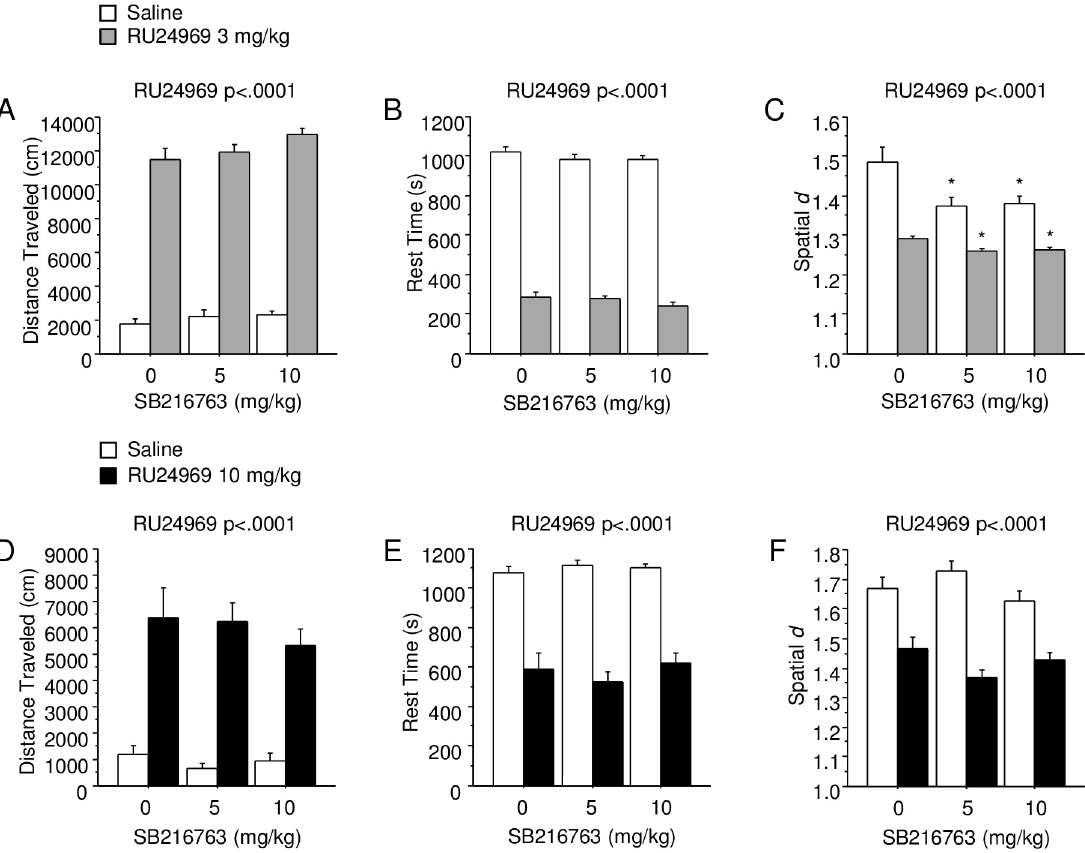
Fig 1. GSK-3 inhibition did not alter RU24969-induced changes in locomotor behavior in the open field test. A—C show distance traveled (A), time spent resting (B), and spatial d (C) for Experiment 3 (n = 13-14/group), in which mice were administered GSK-3 inhibitor SB216763 60 minutes prior to behavioral testing and 0 (white bars) or 3 mg/kg (gray bars) RU24969 35 minutes prior to behavioral testing. D—F show distance traveled (D), time spent resting (E), and spatial d (F) for Experiment 2 (n = 14/group), in which mice were administered GSK-3 inhibitor SB216763 30 minutes prior to behavioral testing and 0 (white bars) or 10 mg/kg (black bars) RU24969 5 minutes prior to behavioral testing. Results expressed as mean ± SEM. � Significant difference from vehicle within pretreatment or treatment groups. SEM: standard error of the